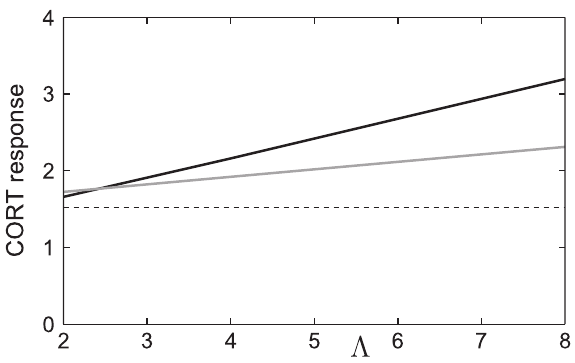
Figure 8. Comparing the CORT response to an acute stress in the oscillatory and non-oscillatory regimes. Basal CRH is set such that basal CORT in the non-oscillatory case matches the maximum level of CORT for the oscillatory case (dashed black). In the non-oscillatory case the response to a stress is independent of the timing of the stress (grey), whilst for the oscillatory case we present the averaged response to an incoming stress applied at every point over a period of oscillation (solid black). L represents the magnitude of the stress. For small stressors, the response in both cases is comparable, whilst for larger stressors the response in the oscillatory case is significantly greater. For comparison, the amplitude of the acute noise stress was estimated to be L ~ 6 : 8 , for which case we see a much greater response within the oscillatory regime.